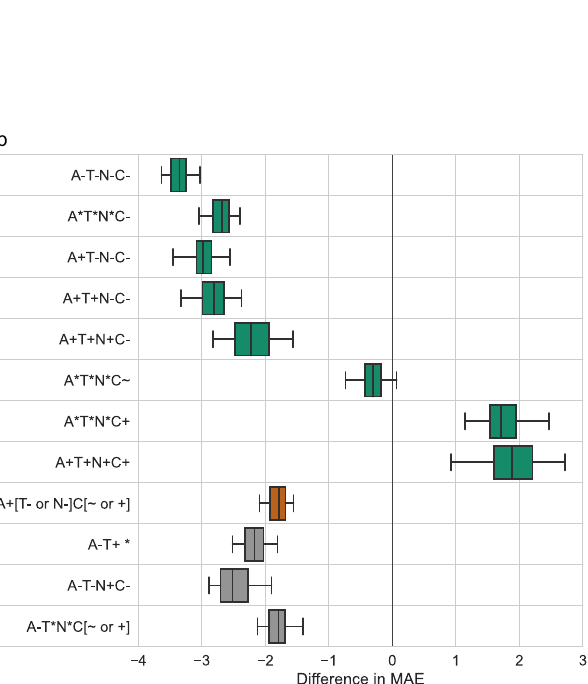
(SNAP) at the bottom (3 bottom rows, in gray). Coef fi cients below zero indicate a lower mean absolute error (MAE) (better forecast) than those for the reference participant and design. For example, if the reference participant comes from J-ADNI instead of ADNI, the prediction of ADAS-Cog13 is more accurate, resulting in a 0.63 point decrease in MAE (95% CI=[0.32, 0.96]). Box plots represent median value, fi rst and third quartiles; whiskers represent the empirical 95% con fi dence interval. Statistics are computed for n =100 resampling of the vali- dation set (see Methods). Source data are provided as a Source Data fi le. MAE mean absolute